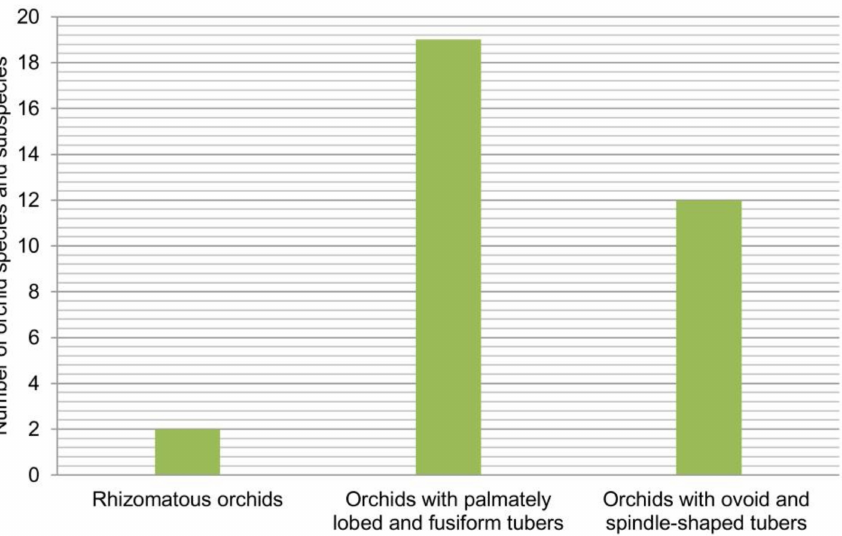
Figure 5. Structure of life forms of orchids of wetland vegetation in the Central